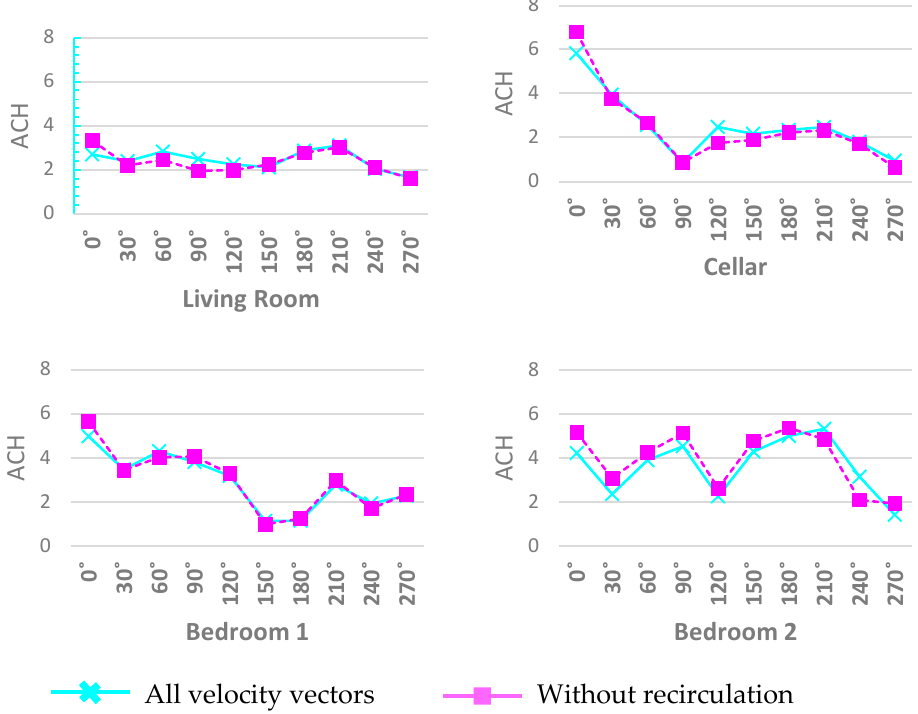
Figure 15. Predicted ACH at living room, cellar, and bedrooms 1 and 2—comparison between two approaches of the integration method.